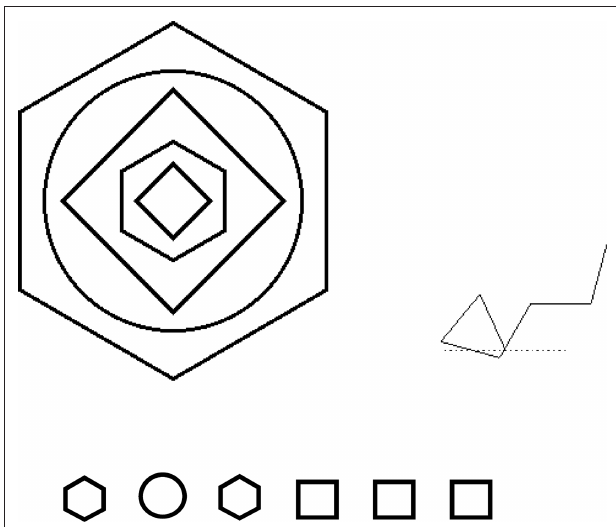
Figure 3 | examples of the types of stimuli used in Pothos and Bailey